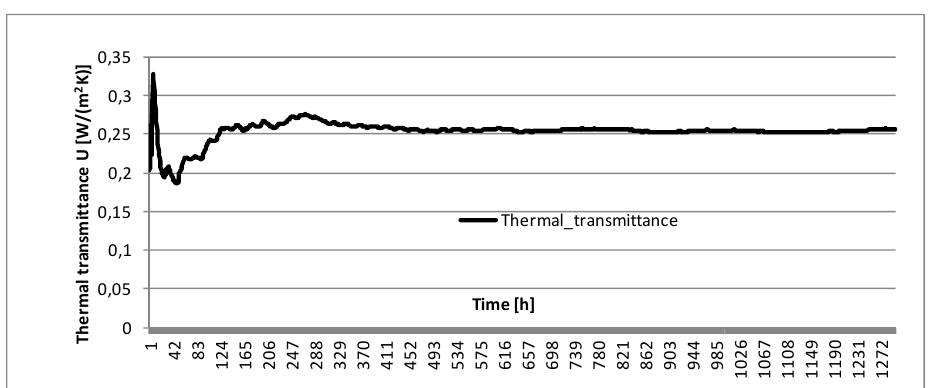
Figure 17. Thermal transmittance coefficient U for the wall insulated with lightweight cellular concrete.